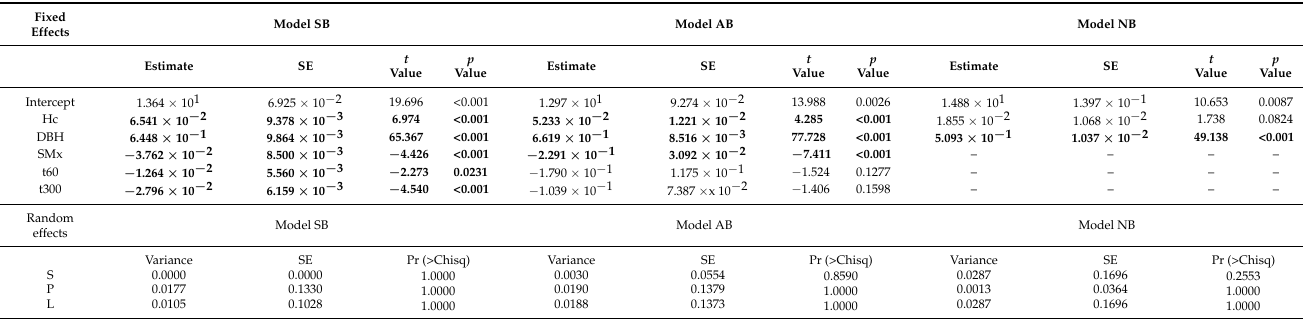
Table 5. Summary of statistical